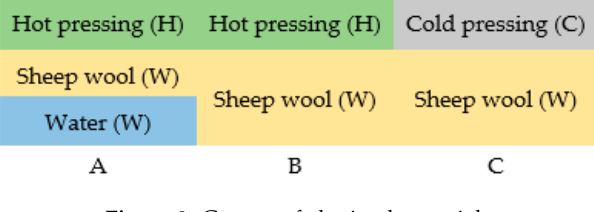
Figure 2. The mold used to obtain material samples by hot pressing [30].